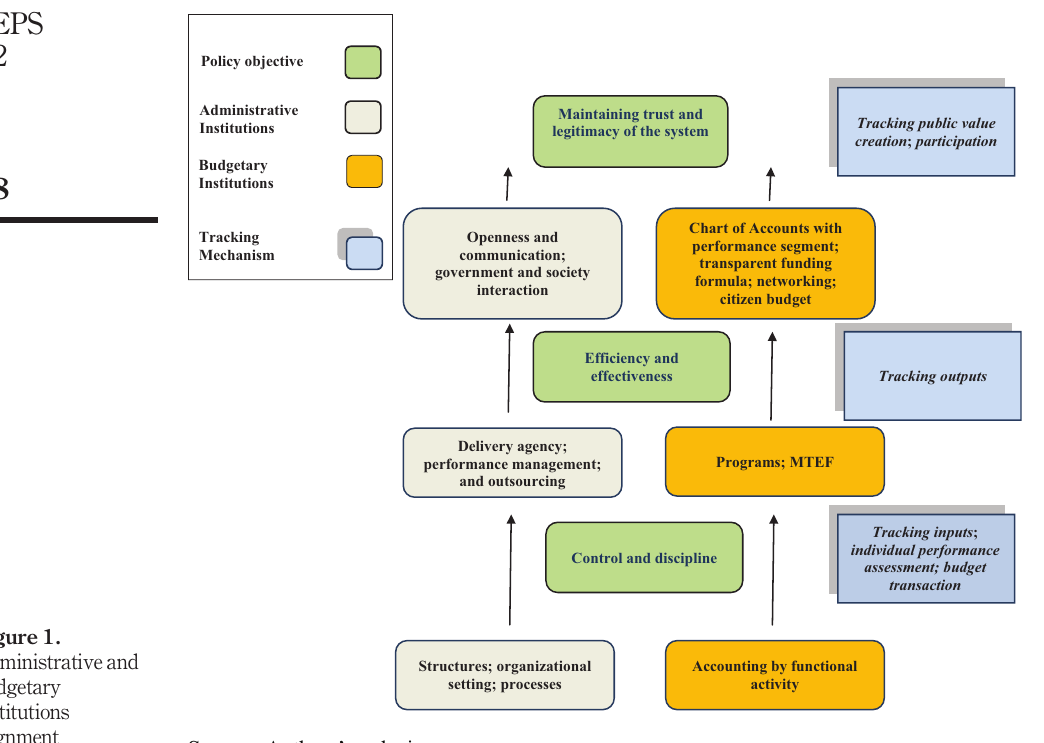
Figure 1. Administrative